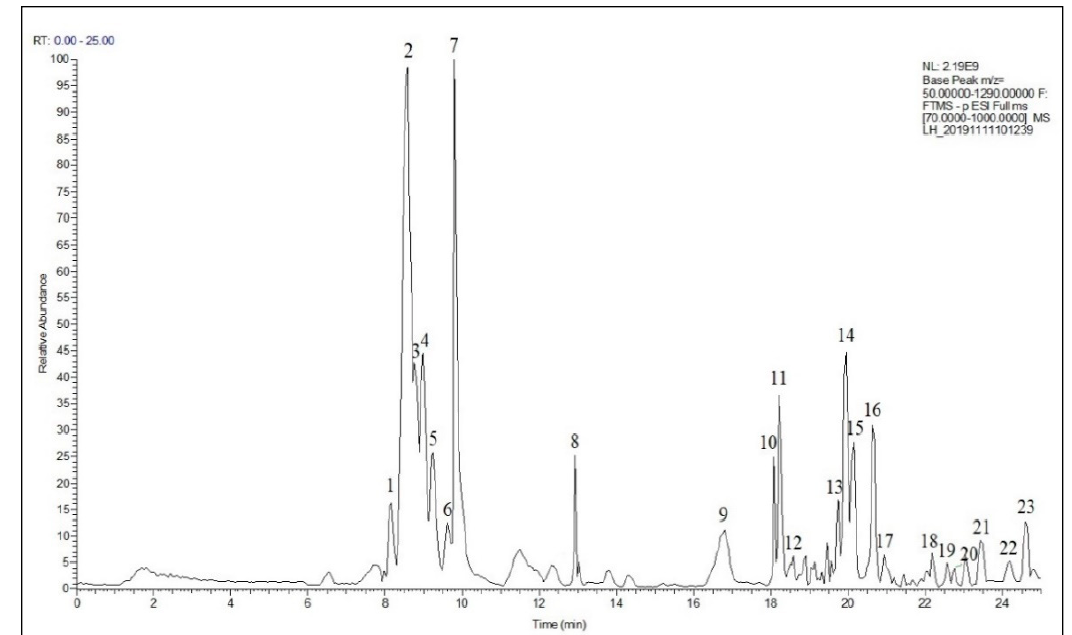
Figure 6. The total ion current of CFEE identified by UHPLC-HESI-MS/MS.